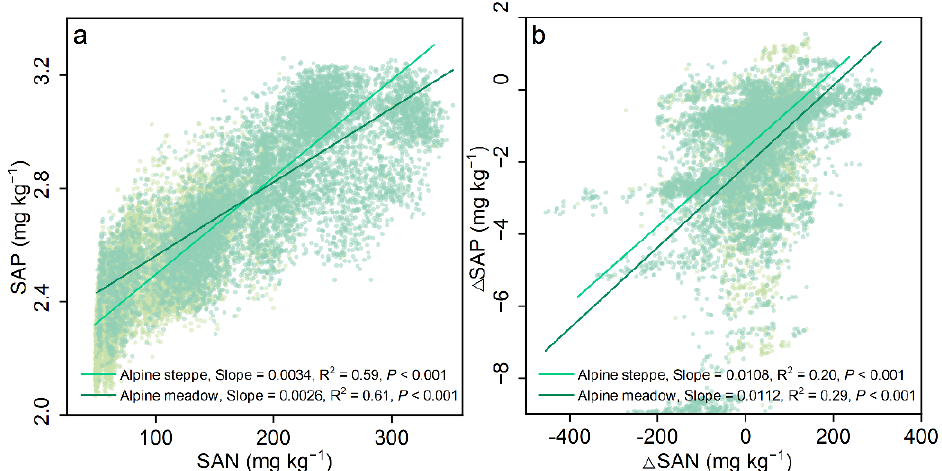
Figure 7. Relationship between SAN and SAP ( a ), Δ SAN and Δ SAP ( b ) in alpine meadows and alpine steppes.